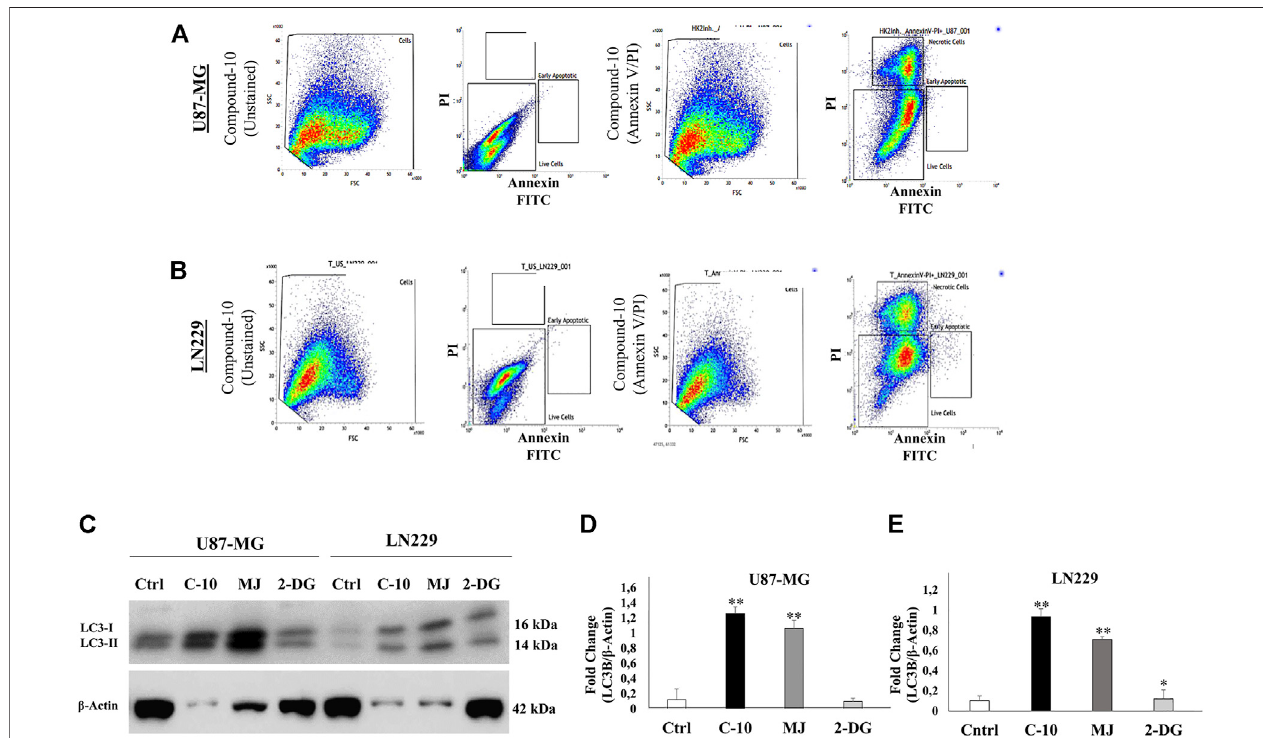
FIGURE 4 | Compound-10(C-10) – mediatedcelldeathanalysisinGBMcells.FlowcytometryanalysisofcelldeathinU87-MGandLN229cellsafter24 hoftreatment with C-10 (5 mM dose). Annexin-V or propidium iodide staining indicates apoptotic and necrotic cell death, respectively (A,B) . Detection of LC3I and LC3II, an autophagy marker, inGBM cells treated withC-10byusing the Western blotmethod (C) . Plotshows quanti fi cationofLC3Iand LC3IIlevelsbyImageJ(LC3I and LC3II band intensities are normalized to β -actin) in U-87 (D) and LN229 cells (E)